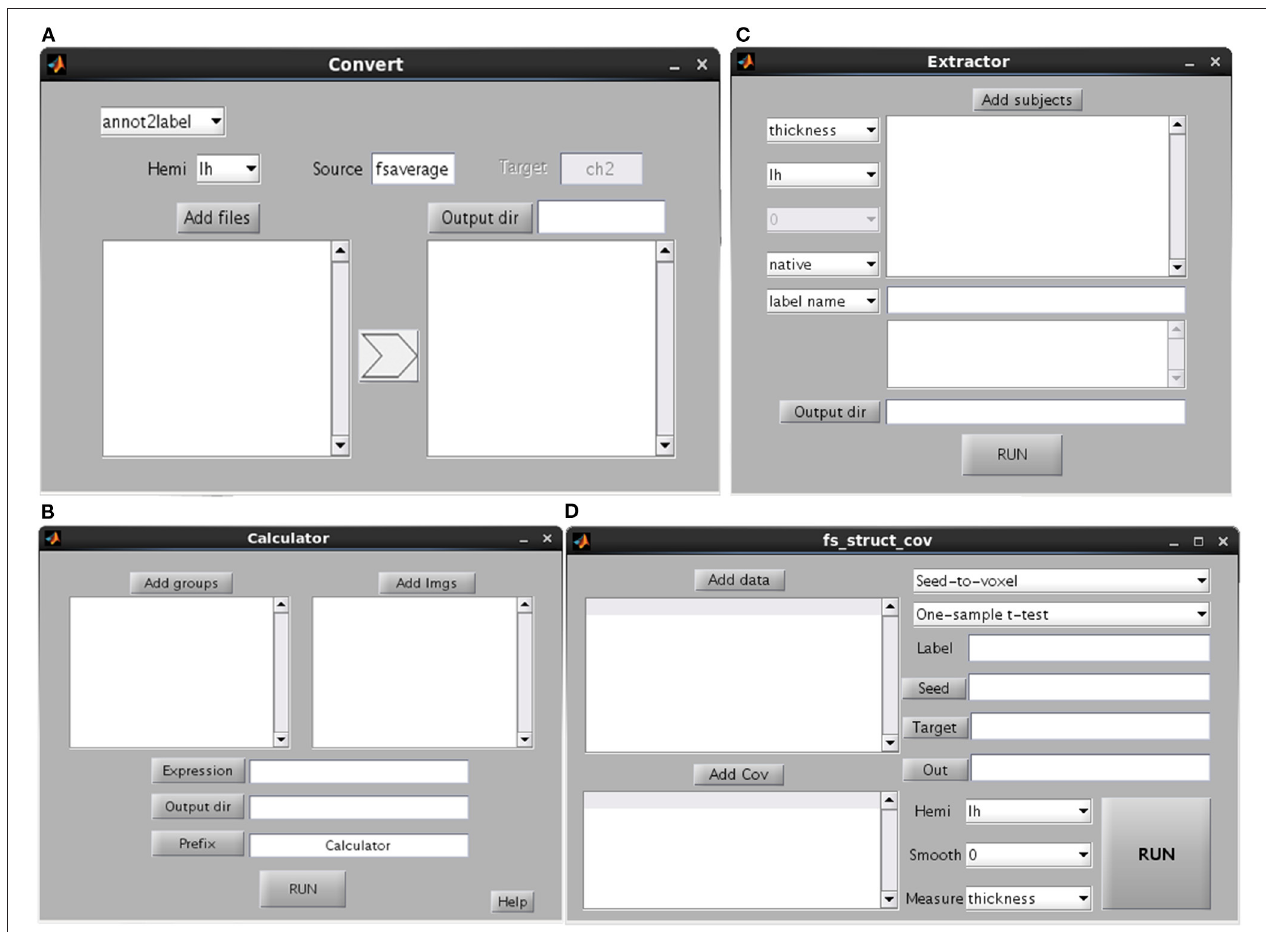
FIGURE 5 | Graphical user interfaces of convert (A) , calculator (B) , extractor (C) and structural covariance connectivity analysis (D) .